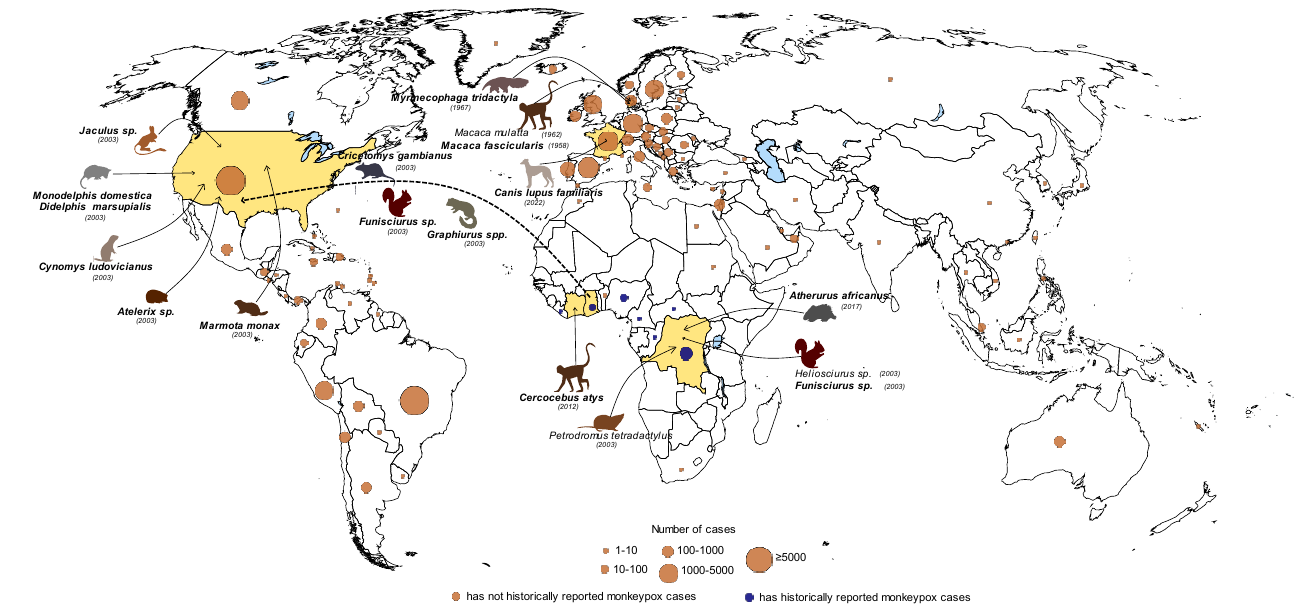
Figure 1. Confirmed cases of monkeypox in humans (orange and dark blue circles) and animals represented by countries. Countries that reported monkeypox infection in animals by PCR or viral isolation (bold italic species name) and serological method (italic species name) are marked with yellow. Dashed line indicates shipment of animals from Africa to the United States. The figure was based on continuously updated data available at the website of Centers for Disease Control and Prevention (data reported until 17 October, 2022) (https://www.cdc.gov/poxvirus/monkeypox/response/2022/world-map.html Accessed on 17 October 2022).